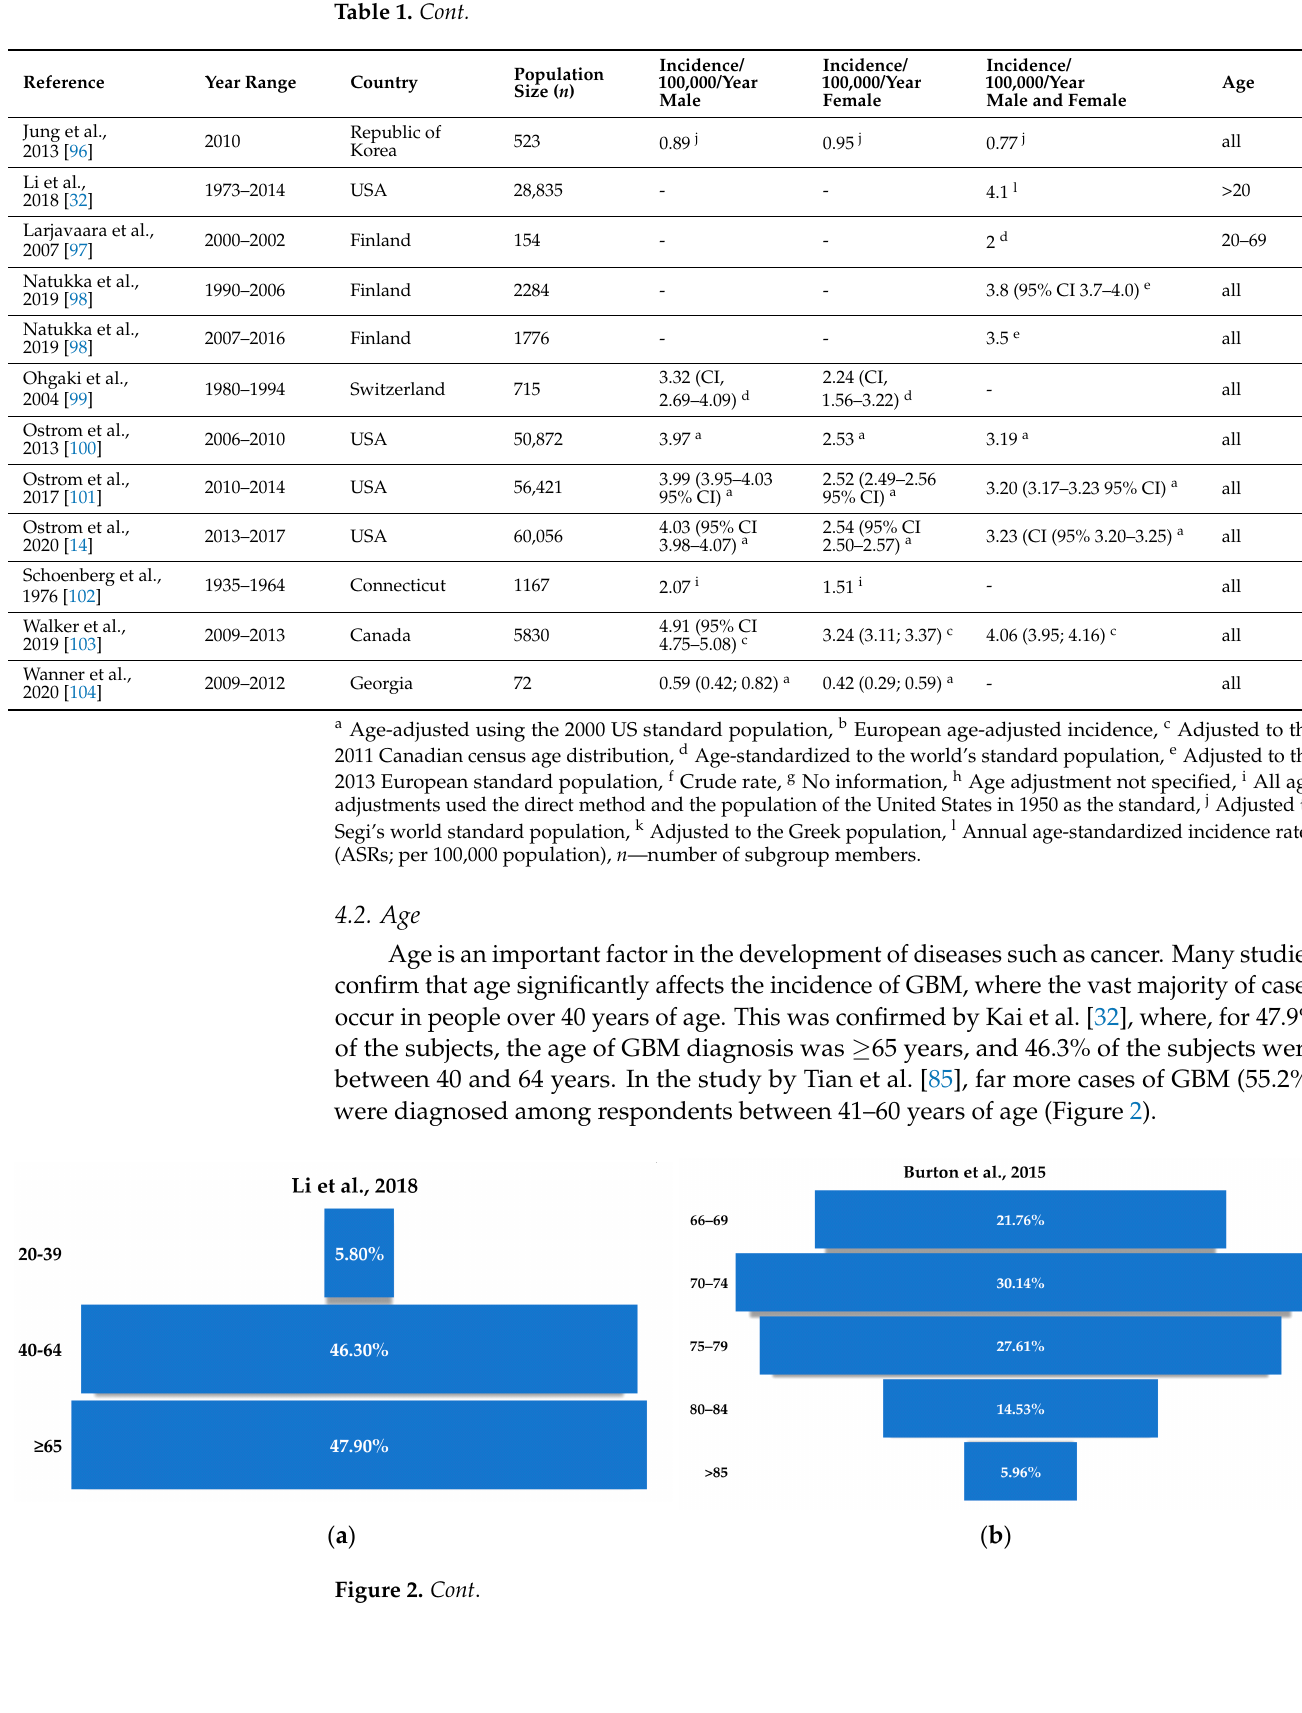
( h ) Figure 2. Age-related incidence of GBM in ( a ) [32], ( b ) [105], ( c ) [85] ( d ) [92] the USA, ( e ) Denmark [31], ( f ) Taiwan [106], ( g ) China [107], and ( h ) India [25]. Figure 3. Age-related incidence of GBM (100,000/years) [14,100,101]. 4.3. Survival GBM is the most aggressive diffuse glioma of the astrocyte lineage and remains an incurable tumor. Table 2 presents survival data for GBM. In most cases, the median sur- vival was less than 15 months. In the study by Lam et al. [24], the median survival was 20, with 46.9% of subjects surviving for up to 2 years after diagnosis. In contrast, Fabbro- Peray et al. [6], Gittelman et al. [92], and Ostrom et al. [101] observed that patients most often lived for up to 1 year after diagnosis. Table 2. Survival time of GBM patients. Reference - Figure 2. Age-related incidence of GBM in ( a ) [32], ( b ) [105], ( c ) [85] ( d ) [92] the USA, ( e ) Denmark [31], ( f ) Taiwan [106], ( g ) China [107], and ( h ) India [25].